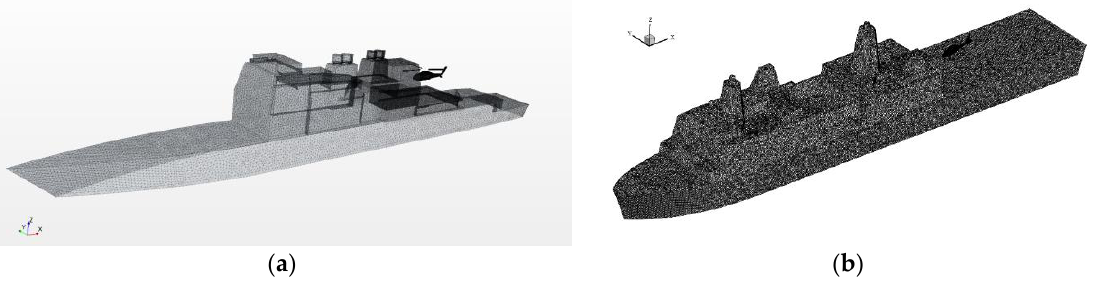
Figure 2. Global mesh of the ship-helicopter surface . ( a ) CG47 and UH60; ( b ) LPD17 and SA365.